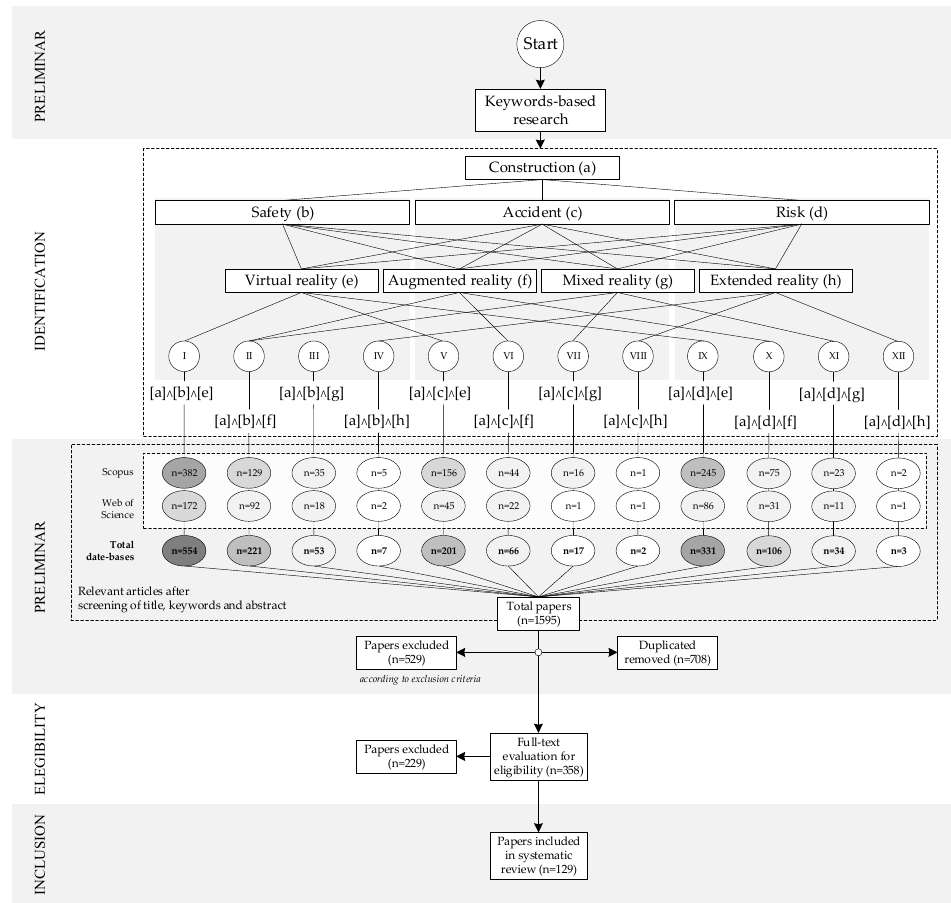
Figure 1. PRISMA workflow for systematic review.